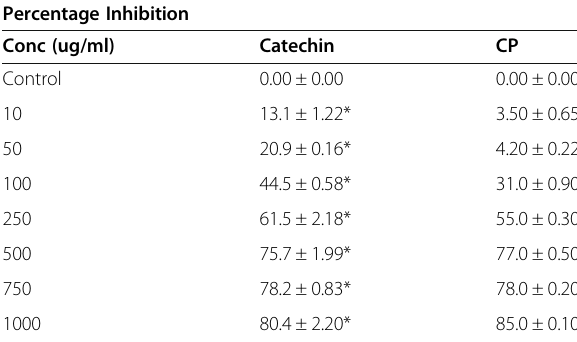
Table 4 H 2 O 2 Scavenging Radical of methanol extract of Calotropis Procera